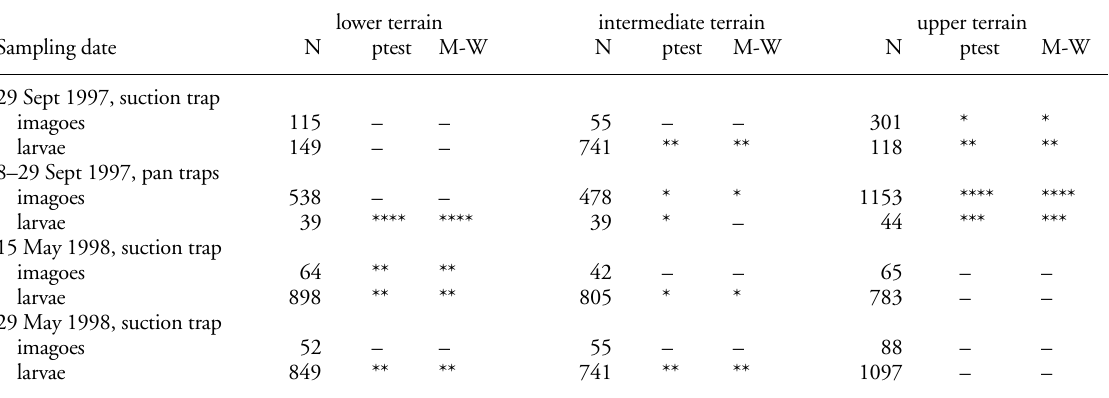
Table 1. Differences between Auchenorrhyncha abundance in mown and unmown plots. N: number of individuals in the two plots, ptest: permutation test, M-W: Mann-Whitney test. Tests are one-tailed, α -values are: *: 0.1, **: 0.05, ***: 0.01, ****: 0.001.